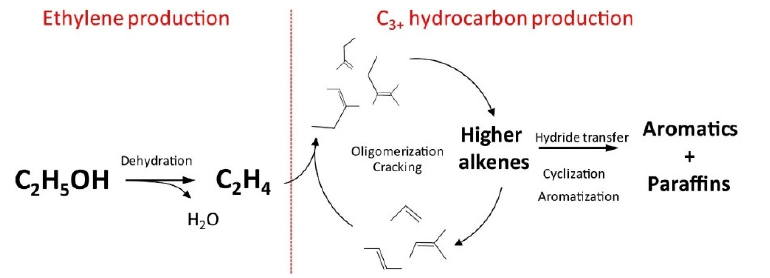
Figure 14. Mechanistic scheme of ethanol conversion to hydrocarbons over zeolite catalysts. Reprinted with permission from [100]. Copyright 2014 Elsevier B.V.